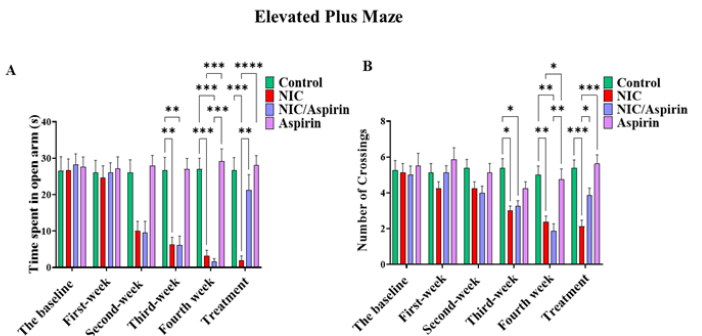
Figure 4. Behavioral testing in the elevated plus maze (EPM) test. ( A ) Time spent in open arm in the EPM in control, NIC, NIC/aspirin, and aspirin groups; ( B ) number of crossings in the EPM in control, NIC, NIC/aspirin, and aspirin groups. Data are presented as mean ± SEM (* p < 0.05, ** p < 0.01, *** p < 0.001, **** p < 0.0001; n = 5 for each group).